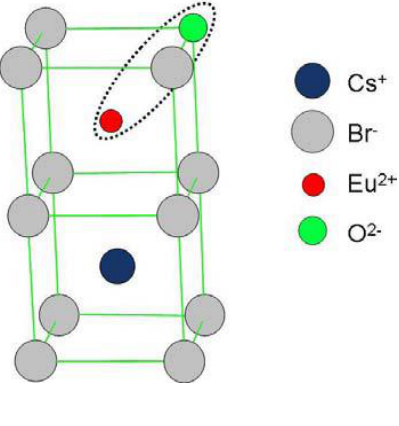
Figure 30. [Eu 2+ -O 2− ] dipole orientation in the CsBr lattice [98] (reproduced with permission from Frank